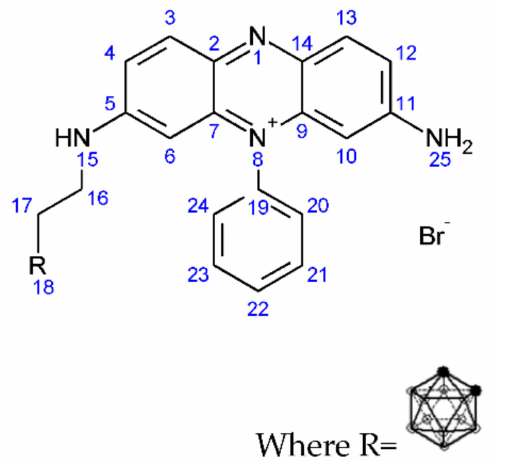
Figure 9. Structure of (3-carboranylpropyl) (3,7-diamino-5-phenylphenazin-5-ium) bromide (6). 1 H NMR: (3-carboranylpropyl) (3,7-diamino-5-phenylphenazin-5-ium bromide):